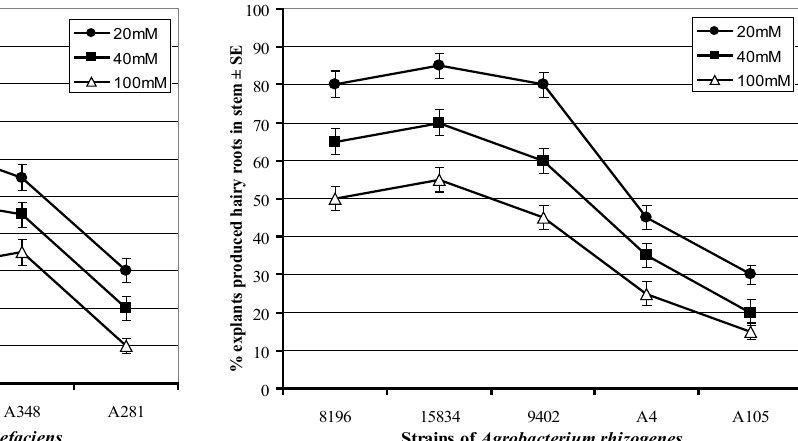
Fig. 6. Effect of acetosyringone conc. on crown gall induction in stem of muskmelon